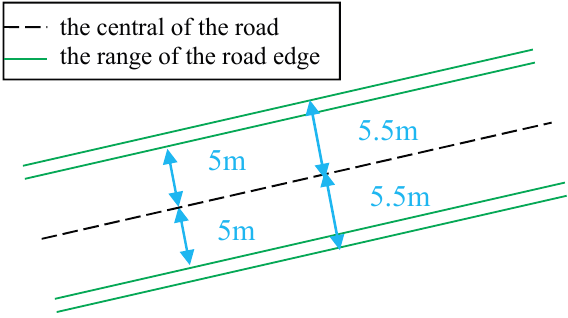
Figure 13. Example of the width range for a carriageway defined by the road “class” in topographic